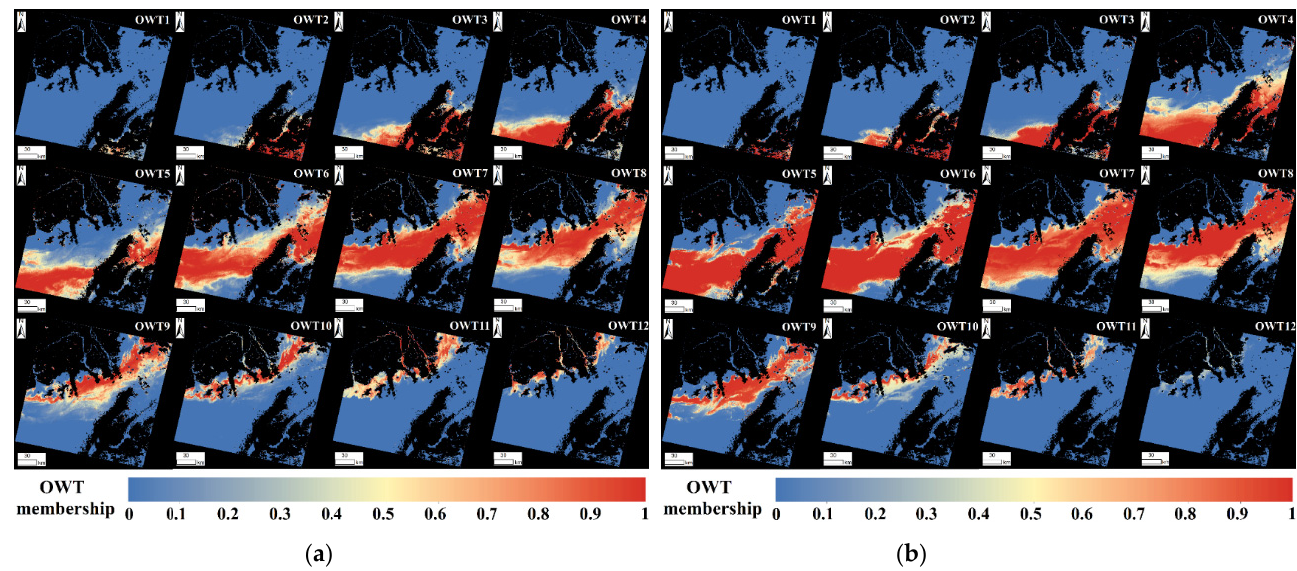
Figure 7. The U-OWT memberships of the Pearl River Estuary’s ( a ) Landsat-8 OLI image on 23 October 2017, and ( b ) Sentinel-3A OLCI image on 23 October 2017. The memberships of U-OWT13/14/15 are not shown here because of their negligible values. The land and cloud pixels are masked.